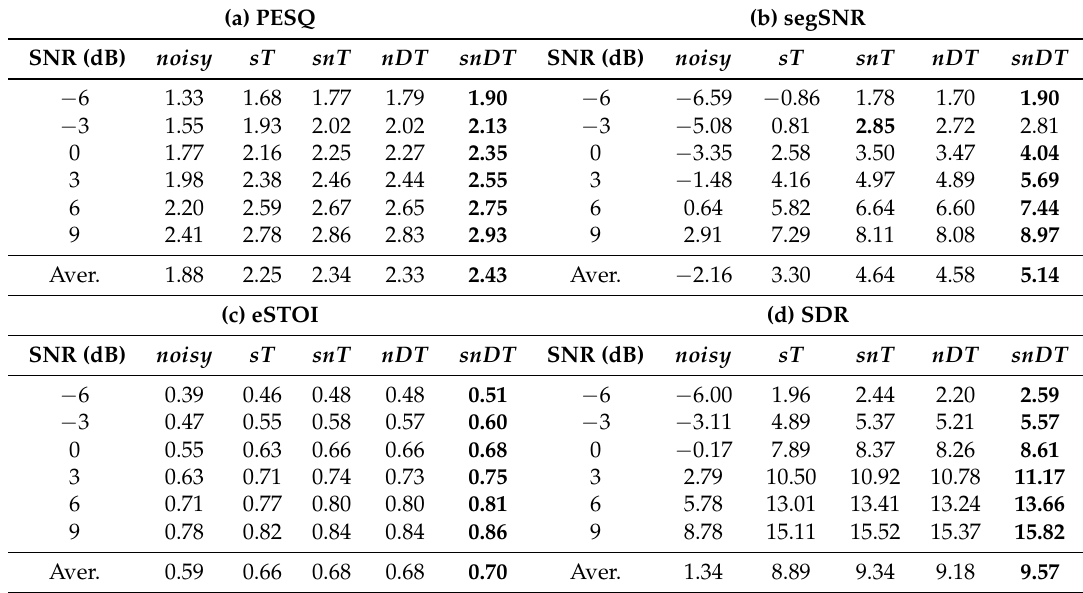
Table 2. Results of PESQ, segSNR, eSTOI, and SDR values of the proposed and baseline networks in the mismatched noise conditions, where − 6 and 9 dB cases are unseen SNR conditions.